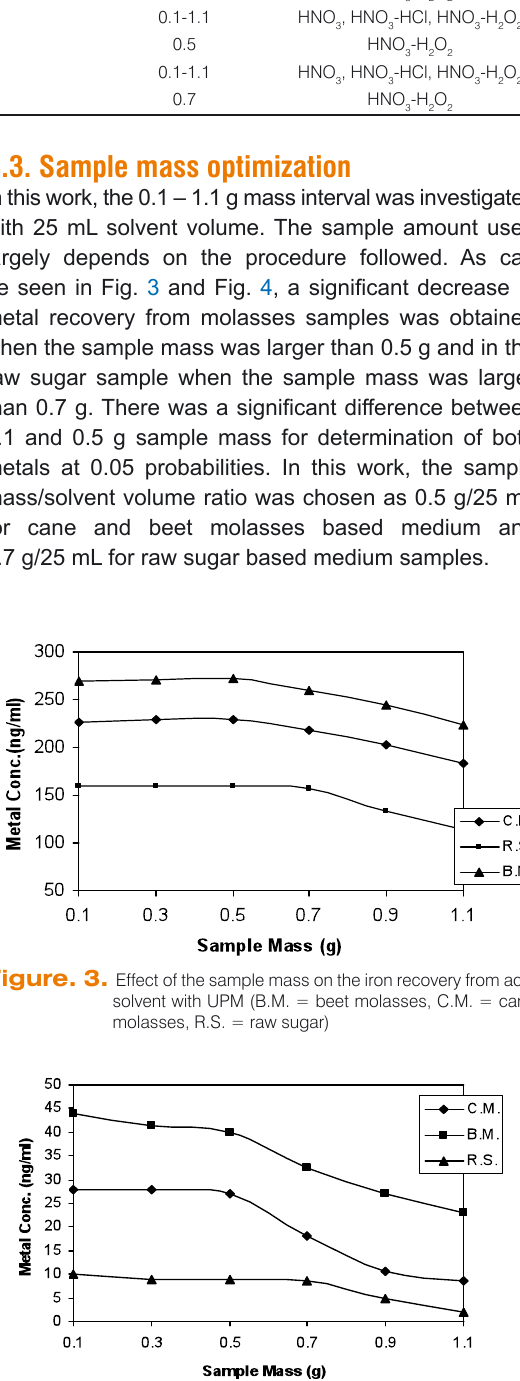
Figure. 2. Effect of sonication time on manganese recovery from CAFM samples (B.M. = beet molasses, C.M. = cane molasses, R.S. = raw sugar).